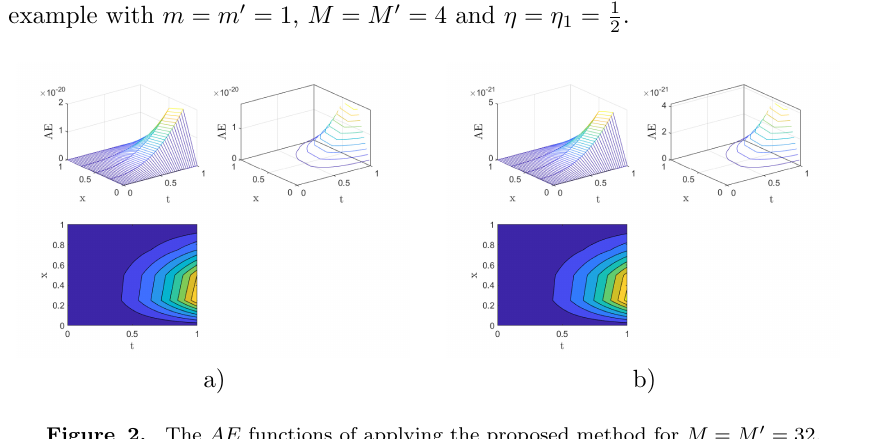
( b ) in Example1. 2